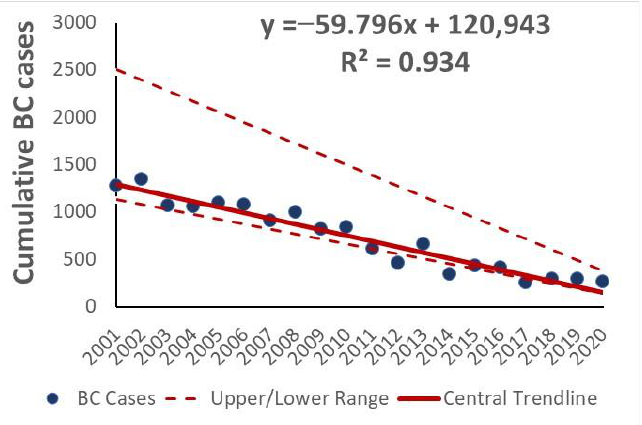
Figure 3. Annual variation in cumulative number of BC due to PM 10 exposure. GAA. Period 2001–2020.